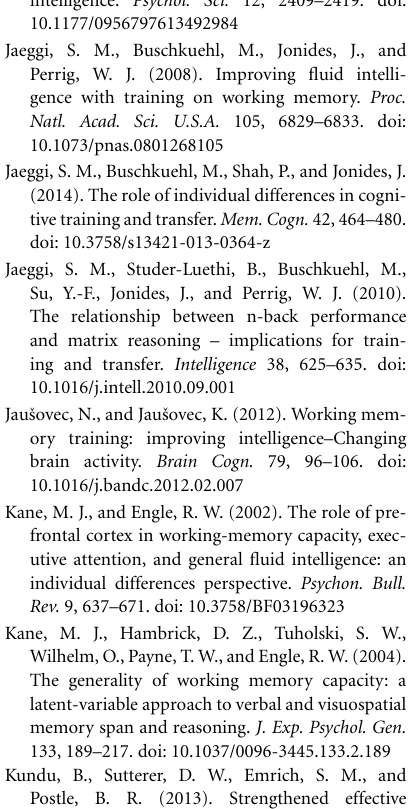
ratios (60–40%), and (D) 3 subpopulations—Unequal ratios (55–35–10%). Histograms represent distribution frequencies; the orange line depicts density estimates. The blue line represents the threshold for p = 0 . 05 (all p -values to the left of the line are significant, indicating unbalanced